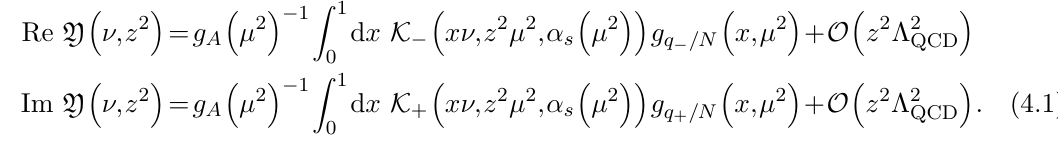
Figure 4 . The real (left) and imaginary (right) components of the reduced pseudo-ITD Y obtained from the SVD applied to the summed ratio R fit ( p z ˆ z, z 3 ; T ) fits for T/a ∈ [6 , 14] (darkened inner errors), with a matrix element fitting systematic estimated using the T/a ∈ [4 , 14] fits (light- ened outer